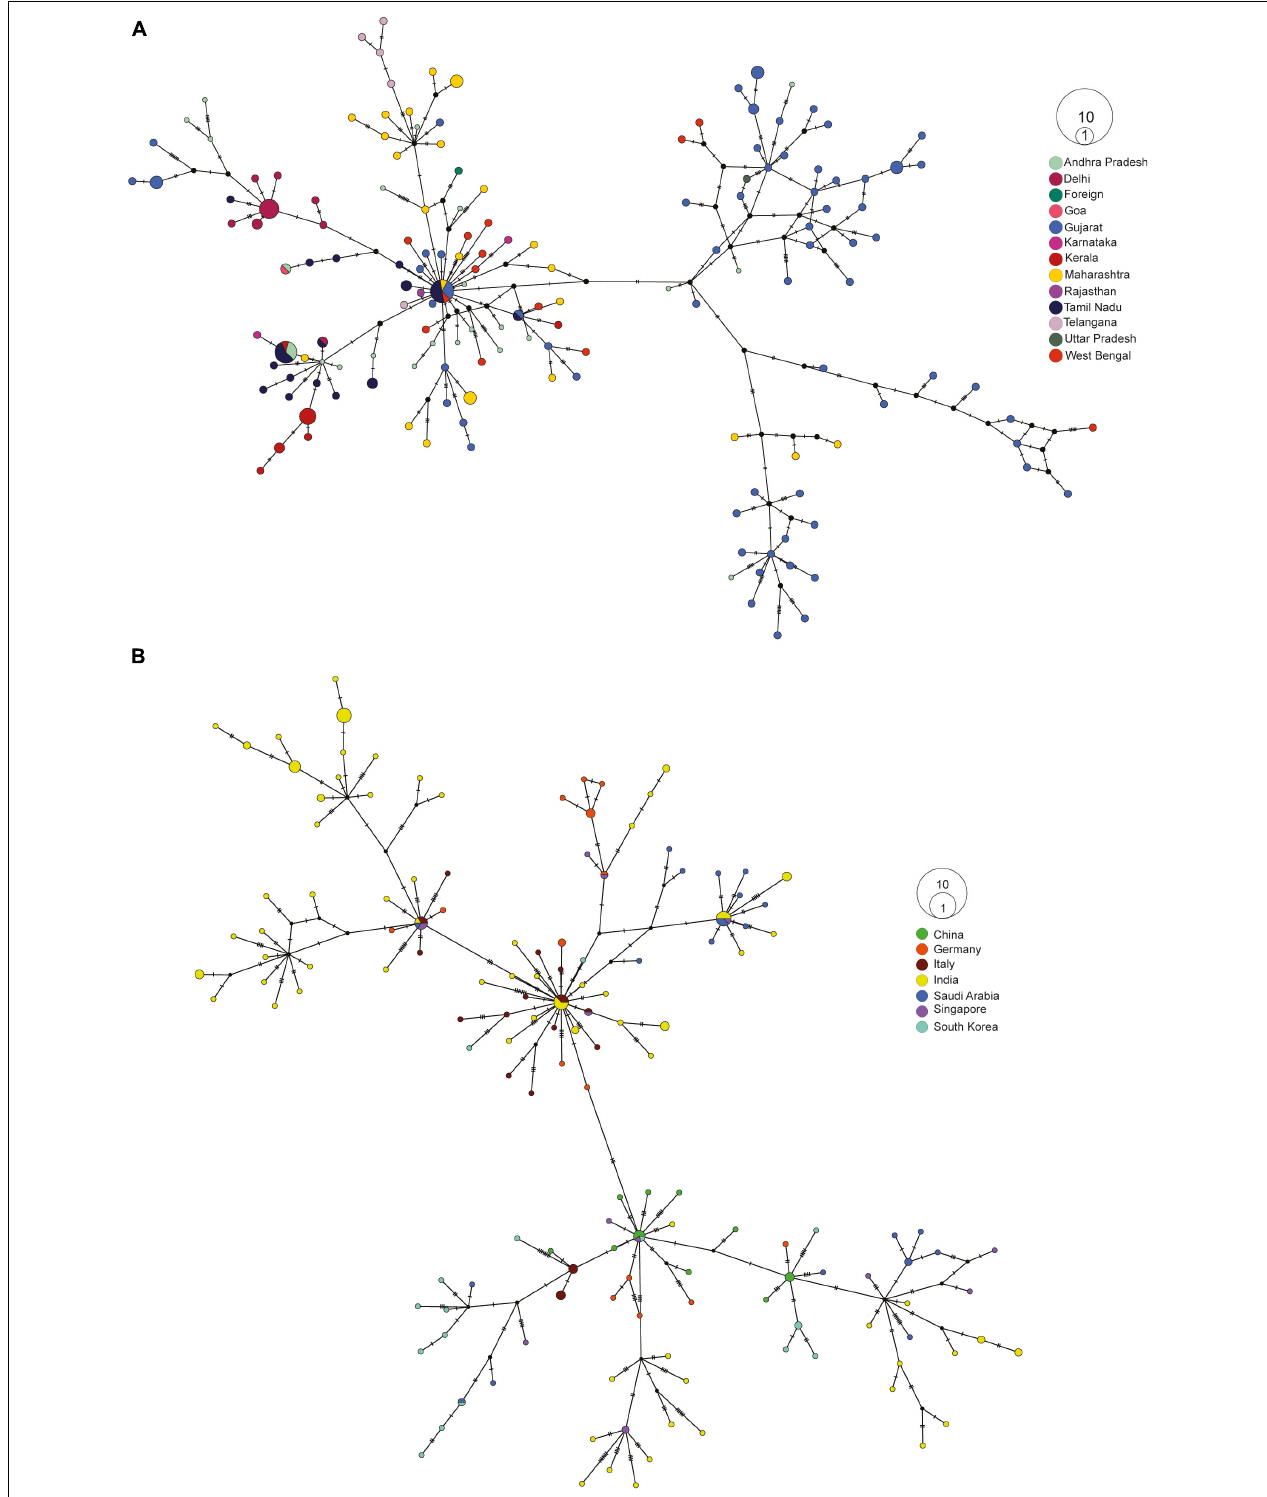
FIGURE 3 | Haplotype network analysis of SARS-CoV-2 sequences. (A) Haplotype network of 202 SARS-CoV-2 whole-genome sequences from our dataset colored by their respective place of migration. (B) Haplotype network of 100 high-coverage SARS-CoV-2 genomes obtained from GISAID (China 15, Germany 23, Italy 25, Saudi Arabia 23, Singapore 14, South Korea 17) combined with 170 samples sequenced from Odisha with less than < 5% N’s present in consensus sequence.